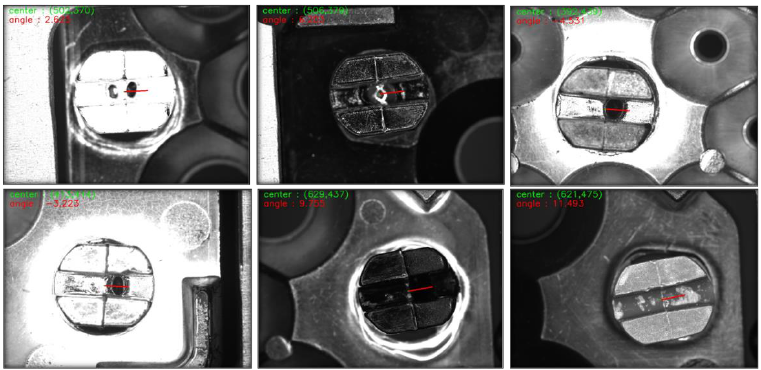
Figure 12. Finalresultimage(thecenterpointandtherotationangleareobtainedbytheleastcircumscribed rectangle and the least square method for the outer contour and the center edge line,